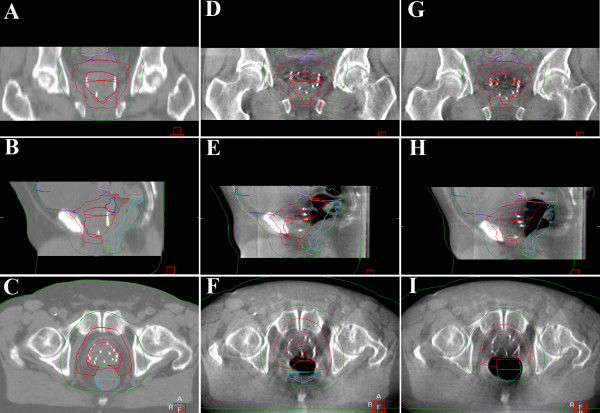
Planning CT (A-C) and CBCT images of a patient immediately before (D-F) and after (G-I) an IMRT fraction. Prostate position differs due to differences in rectal filling during therapy caused by rectal gas not present on treatment planning (in this case -7.4 mm in AP, 1.1 mm in left-right and -1.0 mm in cranio-caudal directions). Planning CT was acquired due to the intitutional policy using enema. This patient marks the maximum unidirectional displacement observed. In general patients with larger differences in rectal filling between treatment planning CT and daily online cone beam CT are asked to empty their rectum and drink water before another treatment attempt.